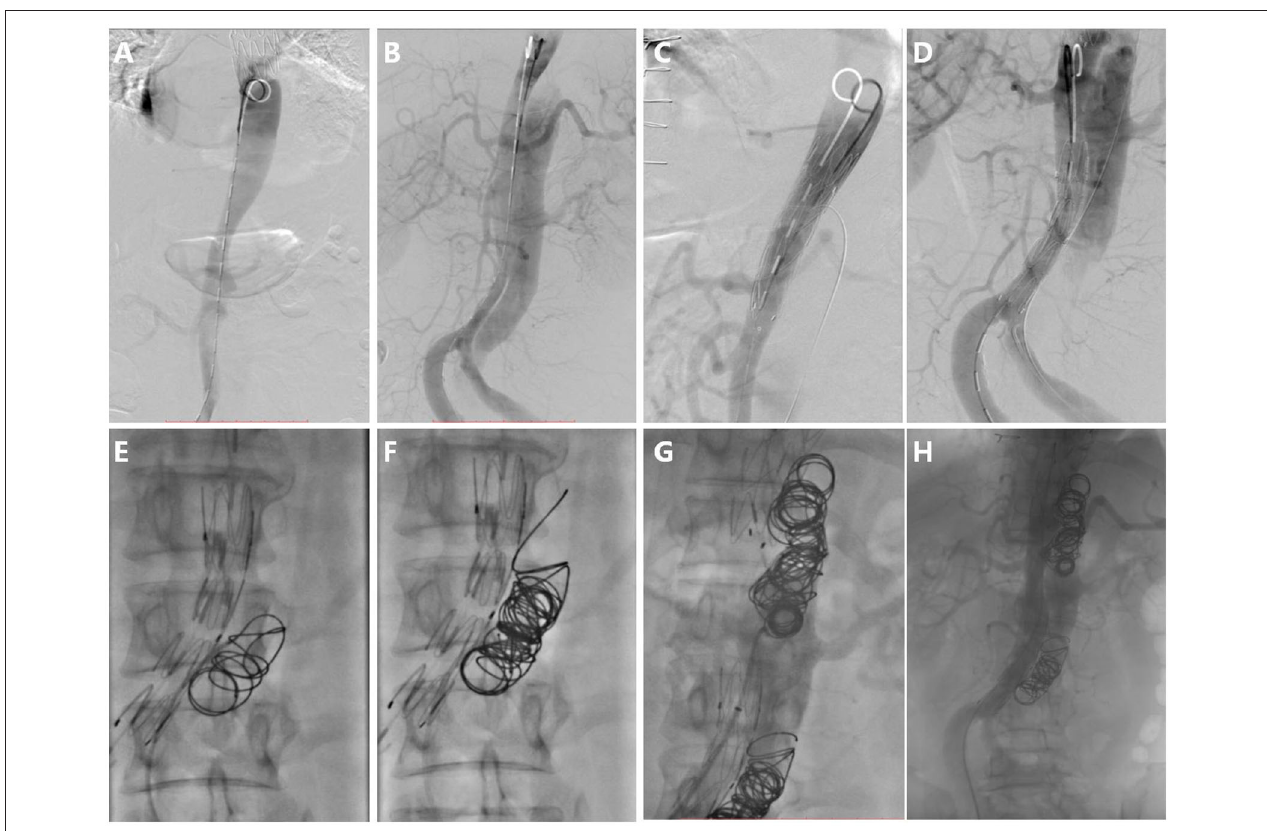
FIGURE 4 | Intraoperative angiography. (A) Digital subtraction angiography in the true lumen, (B) Aortography in the FL, (C) Stent deploying at tears distal to visceral artery, (D) Preserving tear which is proximal and supplies blood to the visceral artery, (E) The first coil was released and drifted to the initial point in the FL, (F) More coils were released from the initial point, (G) Repeating procedure F and forming segmental thrombosis, and (H) Aortography after RBS, showing blood flow decrease in the FL apart from the necessary blood flow track.